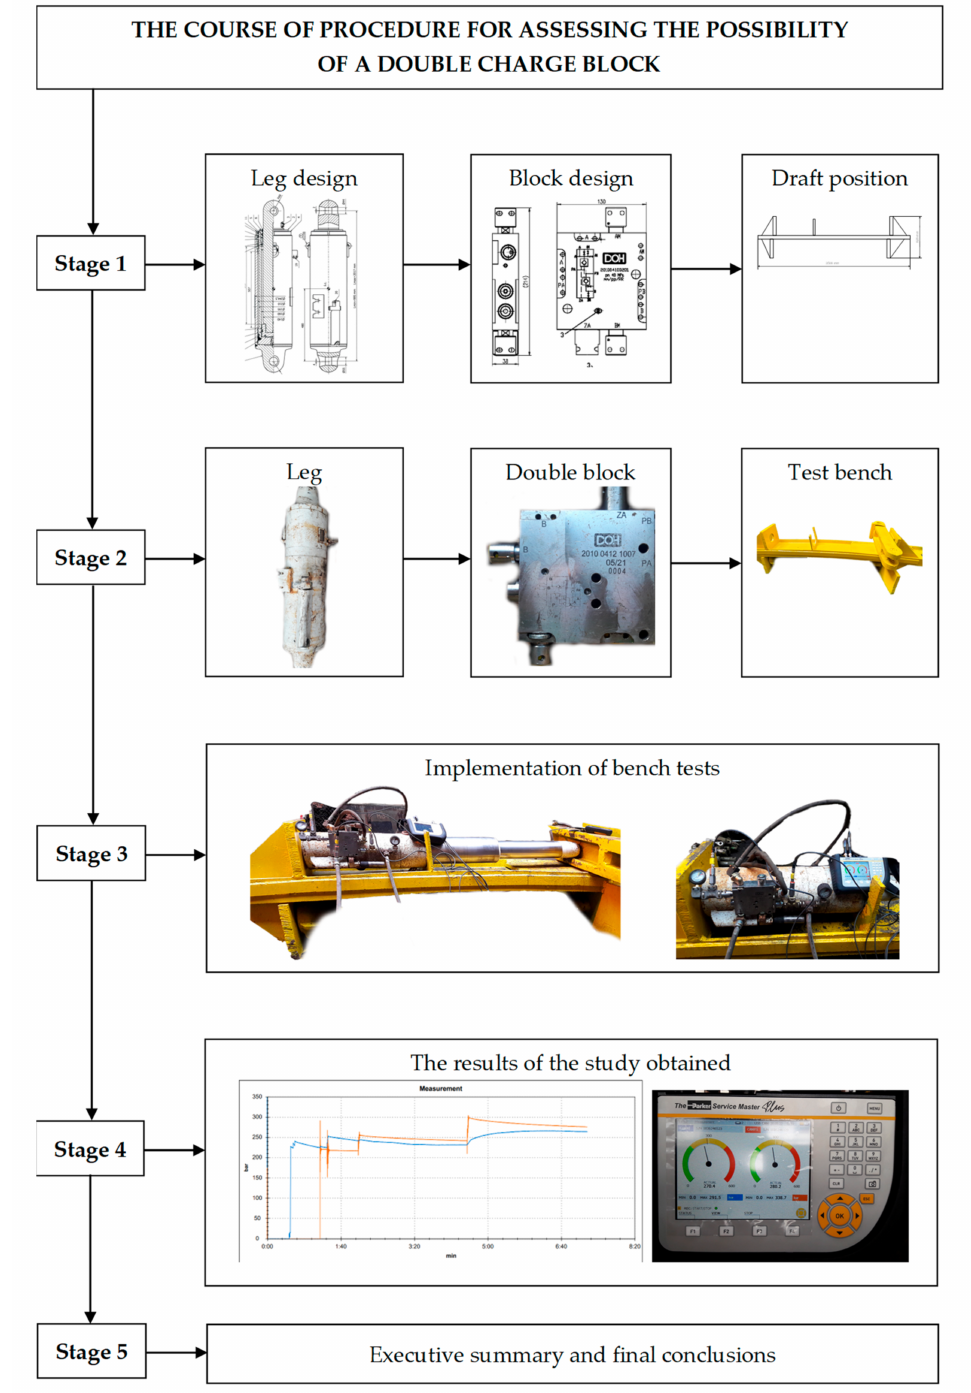
Figure 16. Course of proceedings for assessing suitability based on bench tests of a double block with a charging